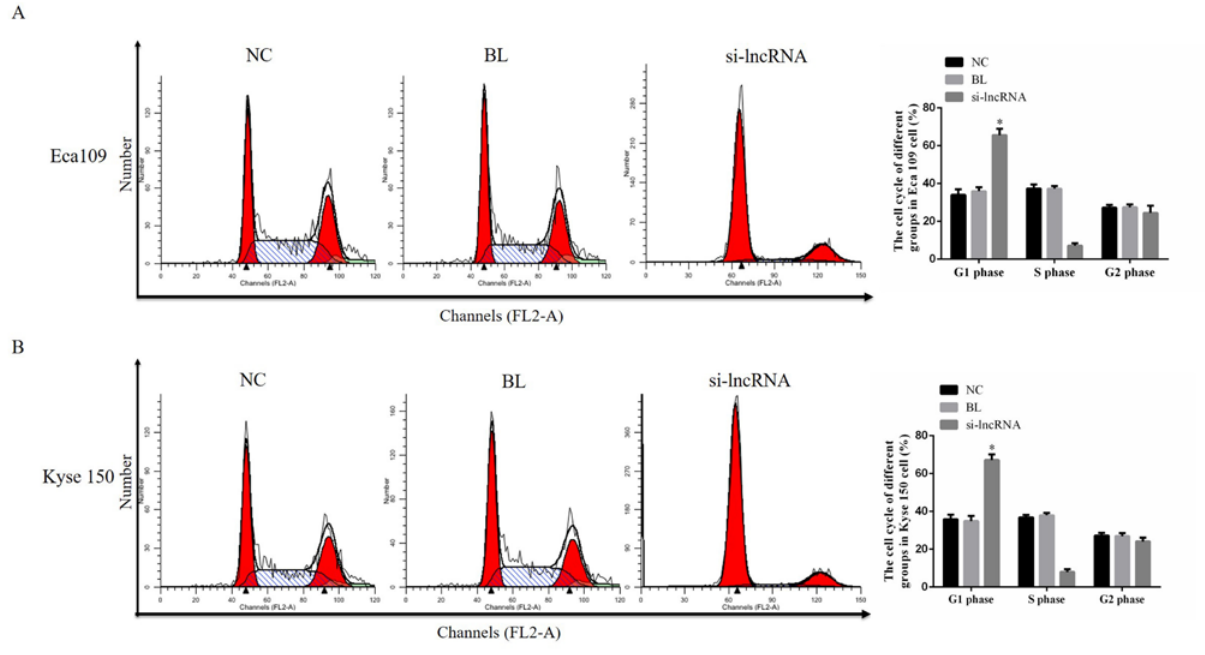
Figure 4. The cell cycle rates of difference groups in Eca 109 and Kyse 150 cells. NC: Normal control group; BL: Blank group; si-lncRNA: si-lncRNA LINC00152 group A. The Eca 109 cell cycle rates of difference groups by flow cytometry. ***: P<0.05, compared with NC group. B. The Kyse 150 cell cycle rates of difference groups by flow cytometry. ***: P<0.05, compared with NC